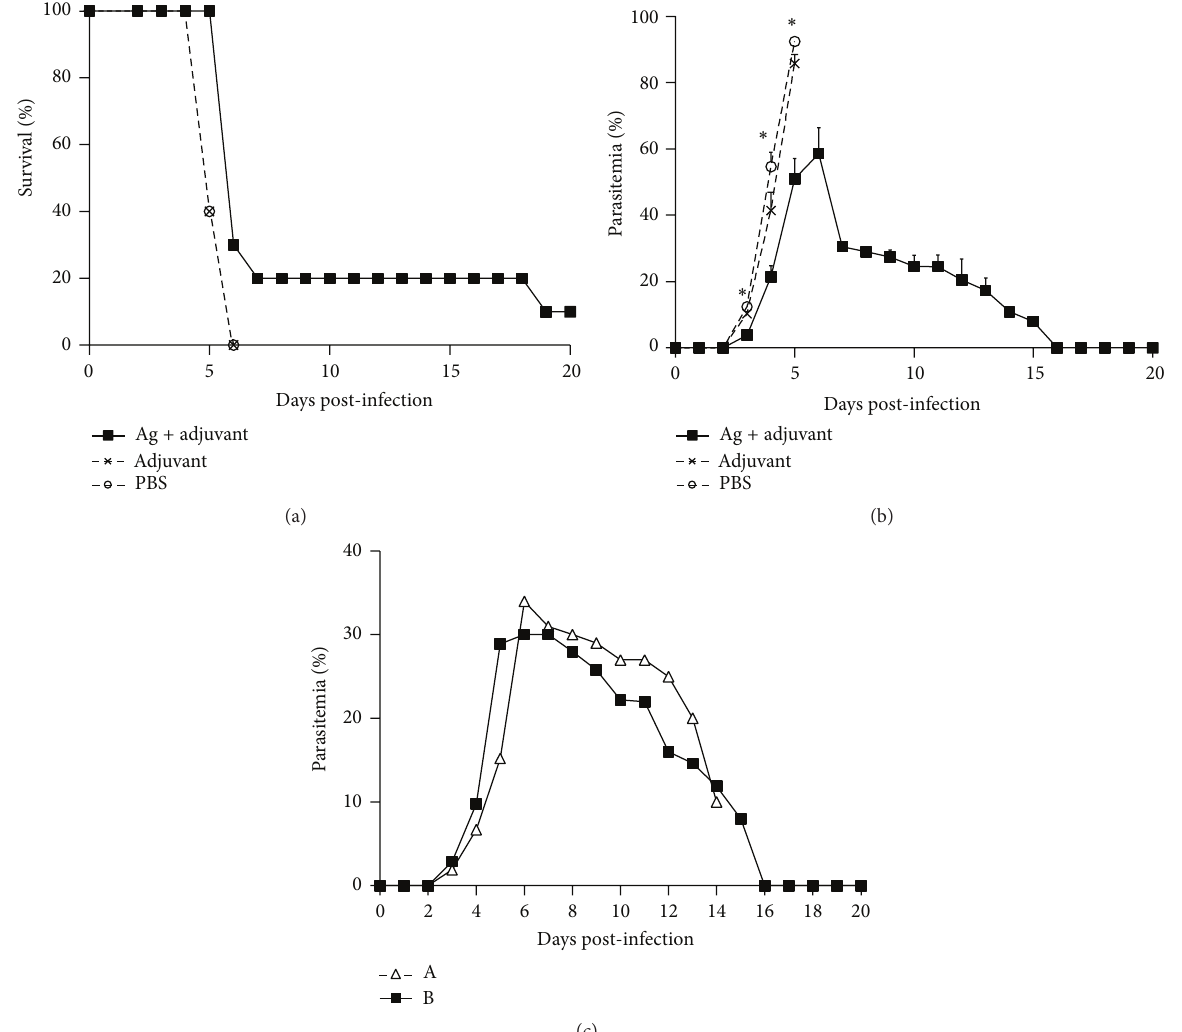
Figure 6: Course of infection in BALB/c mice after antigen and Freund’s adjuvant vaccination. Groups of BALB/c mice were immunized with 10 𝜇 g of purified antigens formulated with Freund’s adjuvant (Ag + adjuvant, 𝑛 = 10 ), Freund’s adjuvant plus PBS (Adjuvant, 𝑛 = 10 ), or PBS alone (PBS, 𝑛 = 5 ). Two weeks after the fourth immunization, mice were challenged with 2 × 10 7 PyL -RBCs. Percentages of (a) survival and (b) parasitemia from a total of 500 RBCs are shown as mean ( ± SEM). (c) Parasitemia course of mice with longer surviving rates after vaccination: mouse which survived around two weeks ( Δ ) or completely survived ( ◼ ). Data is shown as mean ( ± SEM). ∗ 𝑃 < 0.05 comparing group “Ag + adjuvant” to both